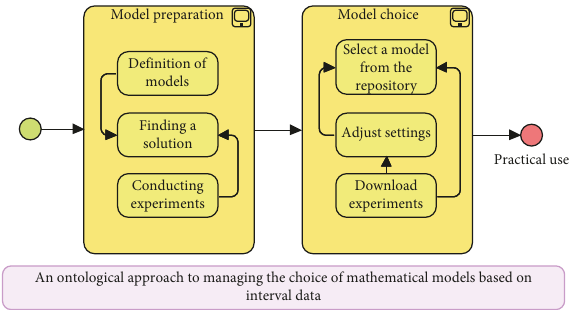
Figure 3: Scheme of implementation of the ontological approach for mathematical modeling based on interval data for practical